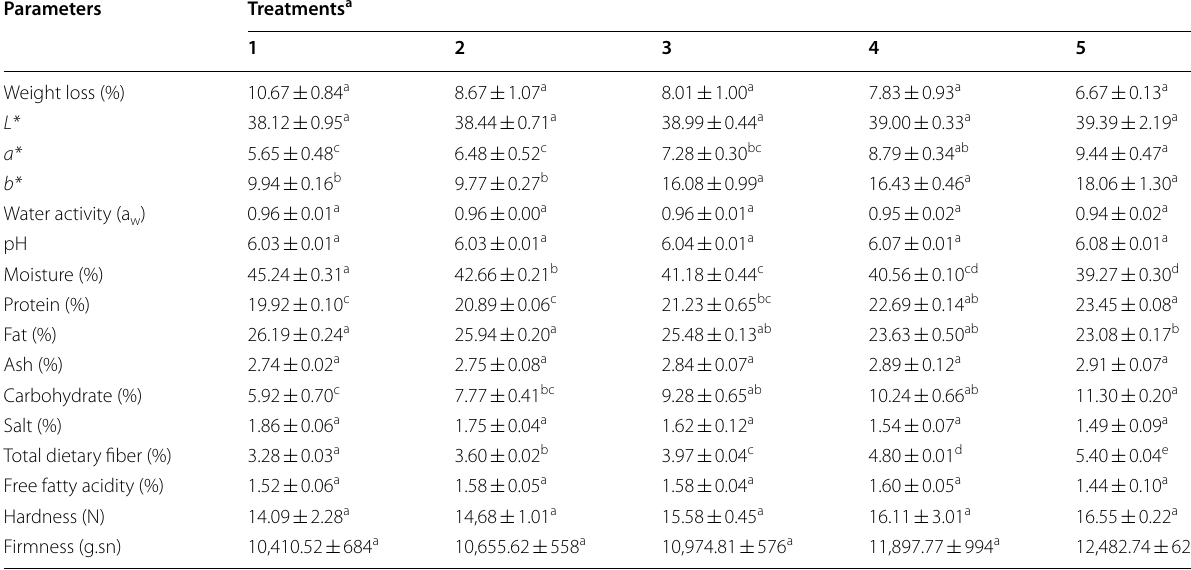
Values are means standard error of three replicates a (1): Cooked control sample, (2): 2% cowpea flour was added cooked sample, (3): 4% cowpea flour was added ± cooked sample, (4): 6% cowpea flour was added cooked sample, (5): 8% cowpea flour was added cooked sample. Means within the same row with diffeerent superscripts are significantly different ( P <